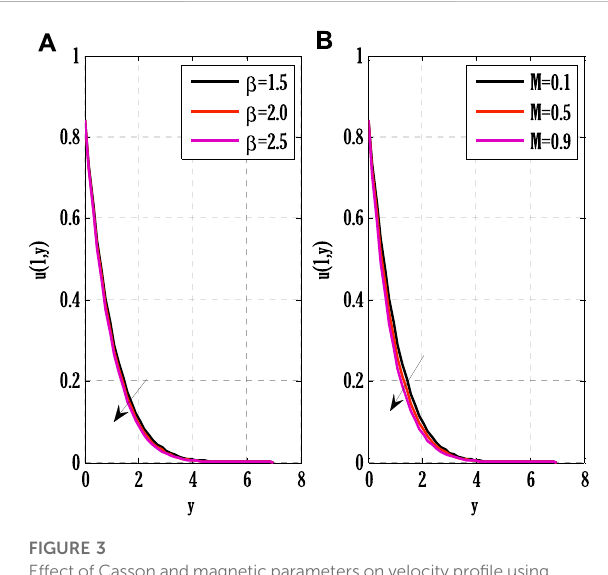
FIGURE 3 Effect of Casson and magnetic parameters on velocity pro fi le using N t (cid:2) 150 , N y (cid:2) 45 , L (cid:2) 7 , t f (cid:2) 1 , E c (cid:2) 0 . 9 , N t (cid:2) 0 . 1 , N b (cid:2) 0 . 15 , P r (cid:2) 1 , S c (cid:2)